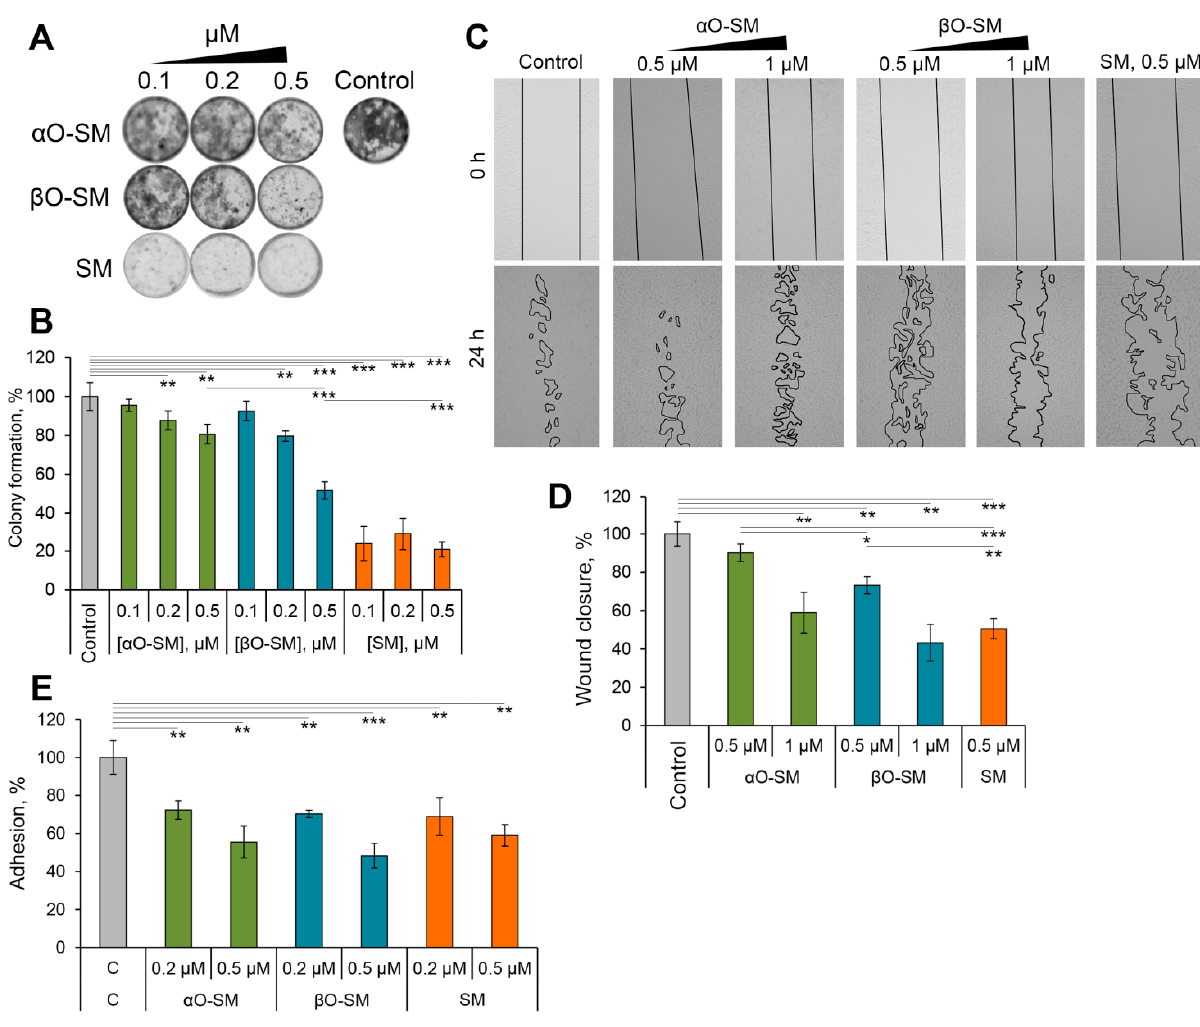
Figure 3. The effect of α O-SM and β O-SM on the pro-metastatic phenotype of B16 melanoma cells. ( A , B ) Clonogenic activity of B16 melanoma cells incubated with α O-SM , β O-SM or SM for 14 days. The data are expressed as mean ± SD of six independent experiments. ( C , D ) Scratch assay showing the effect of SM-epoxides on the motility of B16 cells. Representative images ( C ) and quantitative data ( D ) presented as the mean ± SD of three independent experiments. ( E ) The effect of SM-epoxides on the adhesiveness of B16 cells. The cells were incubated with the evaluated compounds for 24 h, followed by their treatment with TrypLE, washing with PBS and measurement of relative cell numbers by MTT assay. The data are expressed as mean ± SD of five independent experiments. * p < 0.05; ** p < 0.01; *** p < 0.001.